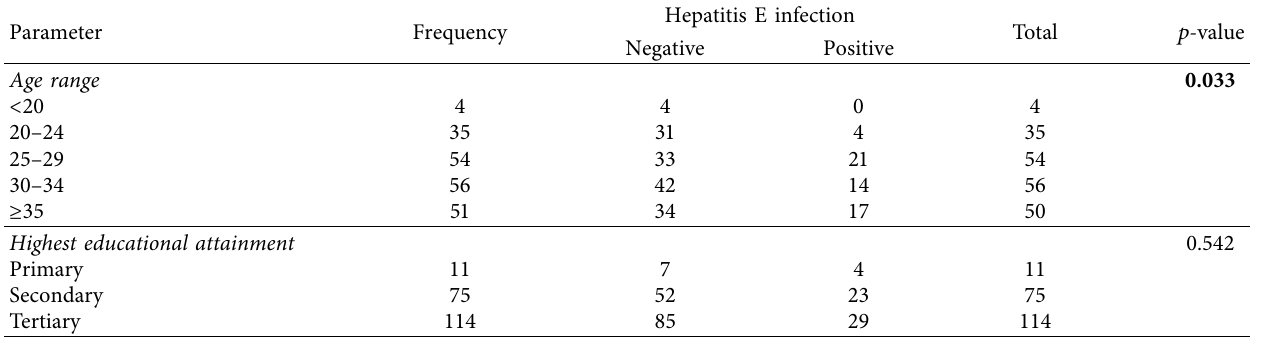
Table 1: Relationship between sociodemographic profile of participants and hepatitis E infection.